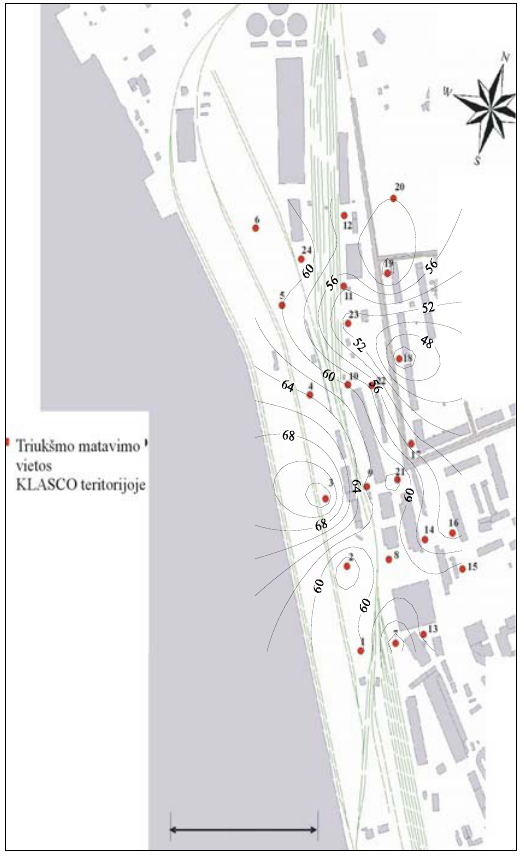
12 pav. Ekvivalentinio triukšmo lygio sklaida dien ą lapkri č io m ė n. Fig 12. Dispersion of reciprocal noise level in the day in